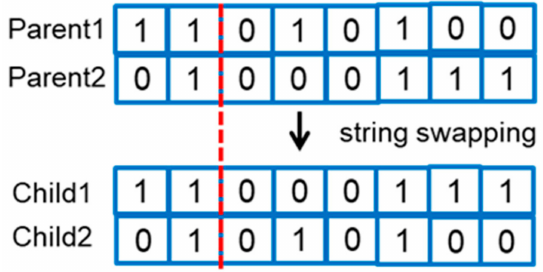
Figure 4. Producing child generations through